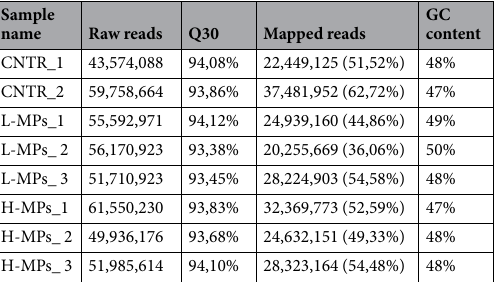
Table 1. Sequencing metrics and quality check results for RNAseq raw reads. Control samples (CNRT), 100